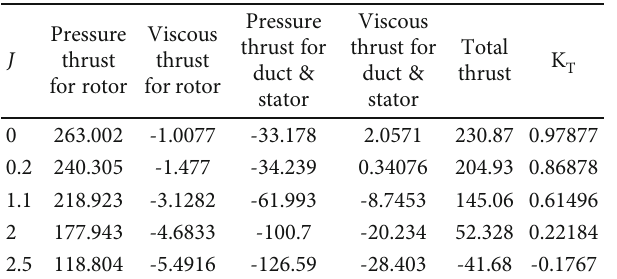
Table 10: Torque force calculated for the linear jet system without a